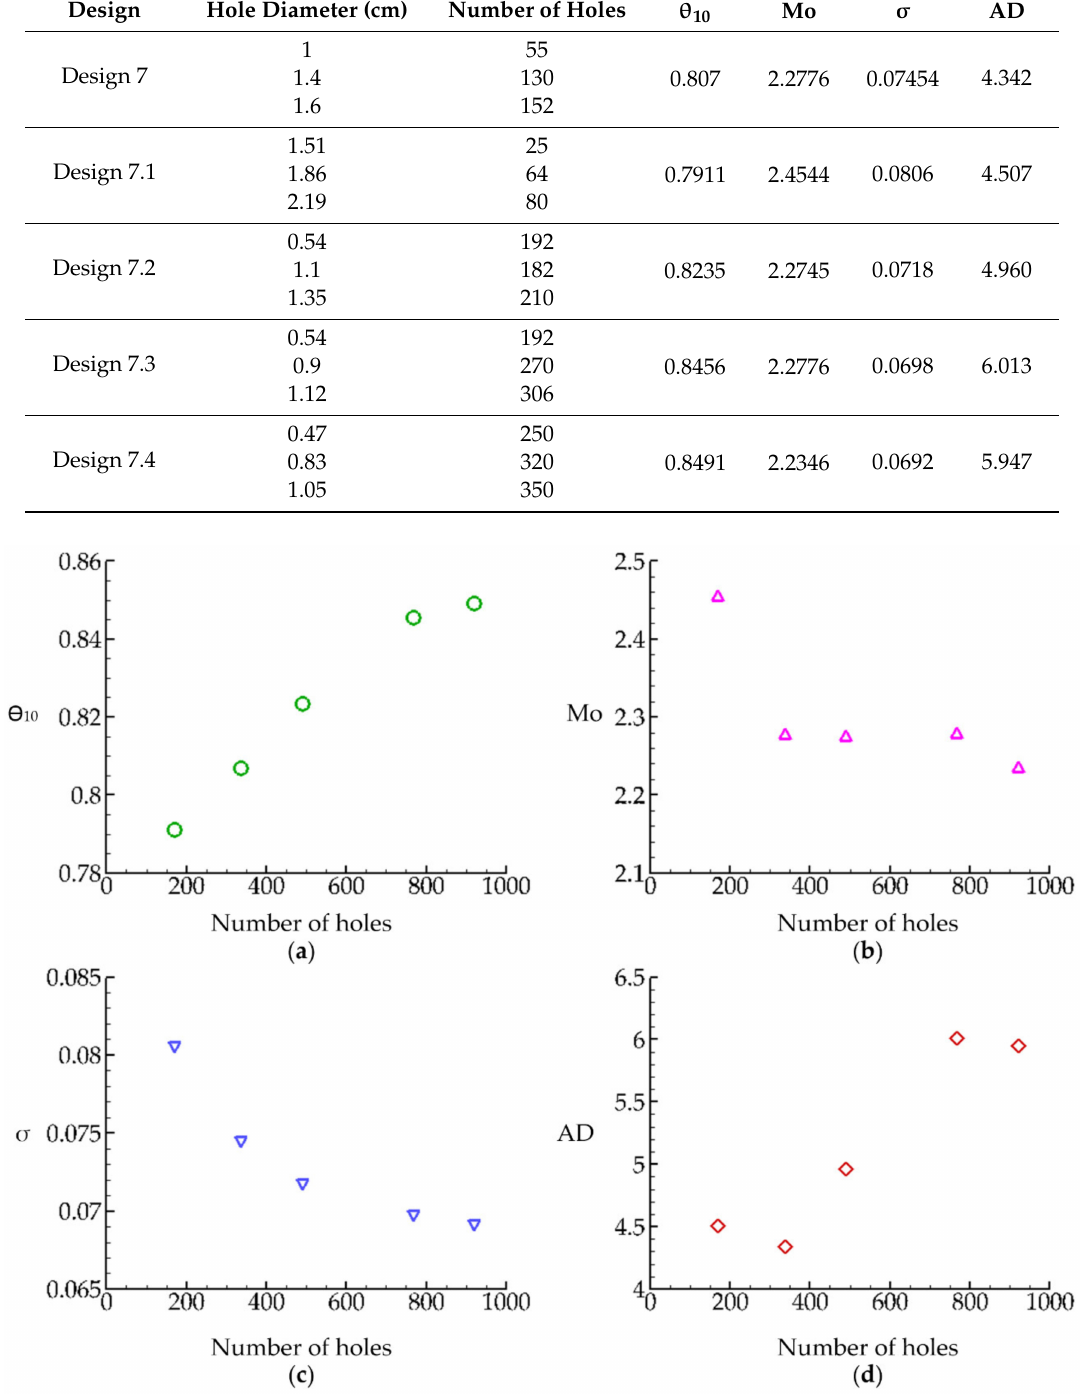
Figure 9. Variation of e ffi ciency indexes with the number of holes for the constant solidity ratios of 95% in Section 1, 80% in Section 2 and 65% in Section 3: ( a ) ba ffl ing factor, ( b ) Mo index, ( c ) dispersion index and ( d ) AD